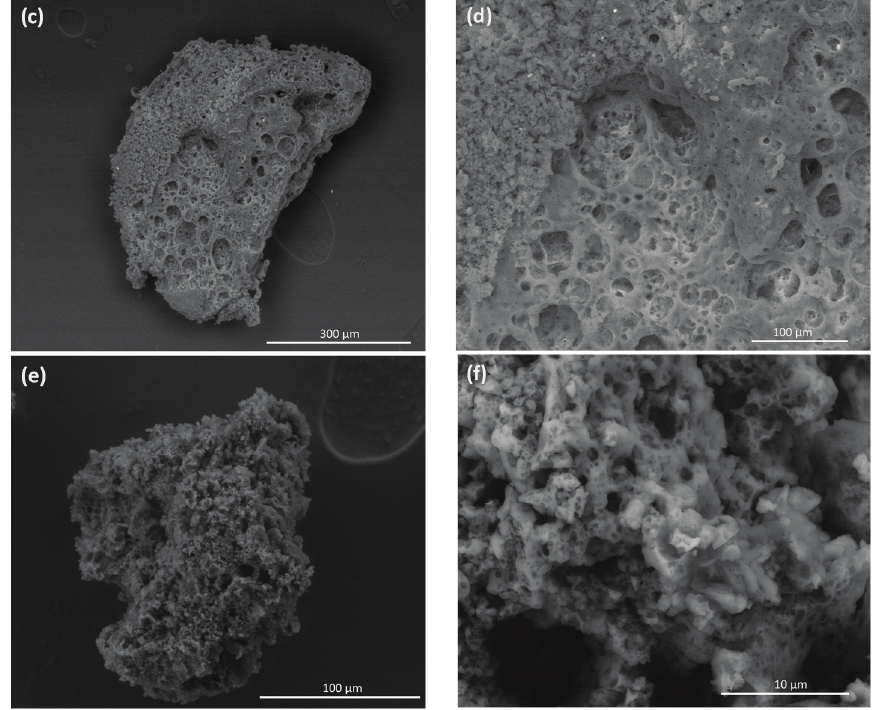
Figure 9. SEM micrographs of original Kraft lignin and their respective zooms ( a , b ); control Kraft lignin extracted from the [C 4 C 1 mim][OTf]/[C 4 C 1 mim][PF 6 ] binary system without enzyme ( c , d ) and lignin oleate extracted from [C 4 C 1 mim][OTf]/[C 4 C 1 mim][PF 6 ] binary system after transesterification catalyzed by the immobilized lipase B from Candida antarctica ( e , f